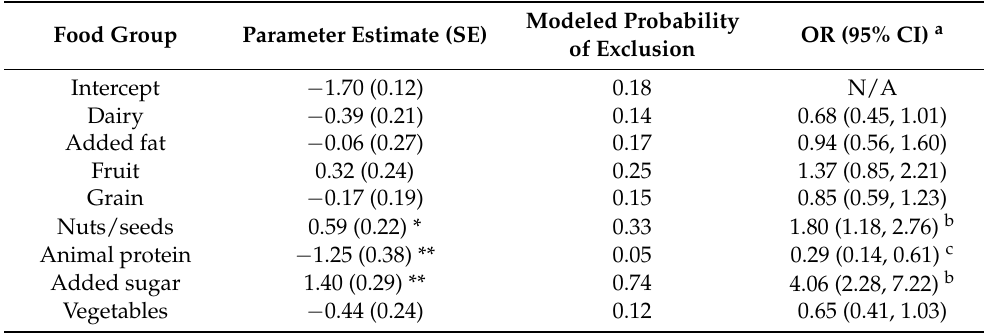
Table 3. Odds of food groups not being reported (excluded) during an ASA24 recall in overweight and obese female respondents.